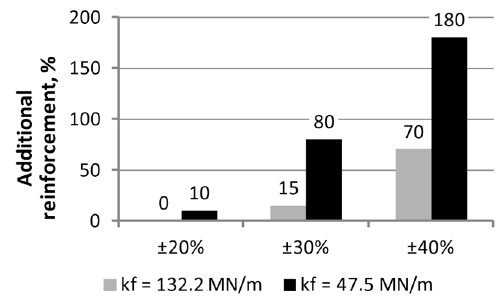
Fig. 16. Additional reinforcement in the upper part of the floor